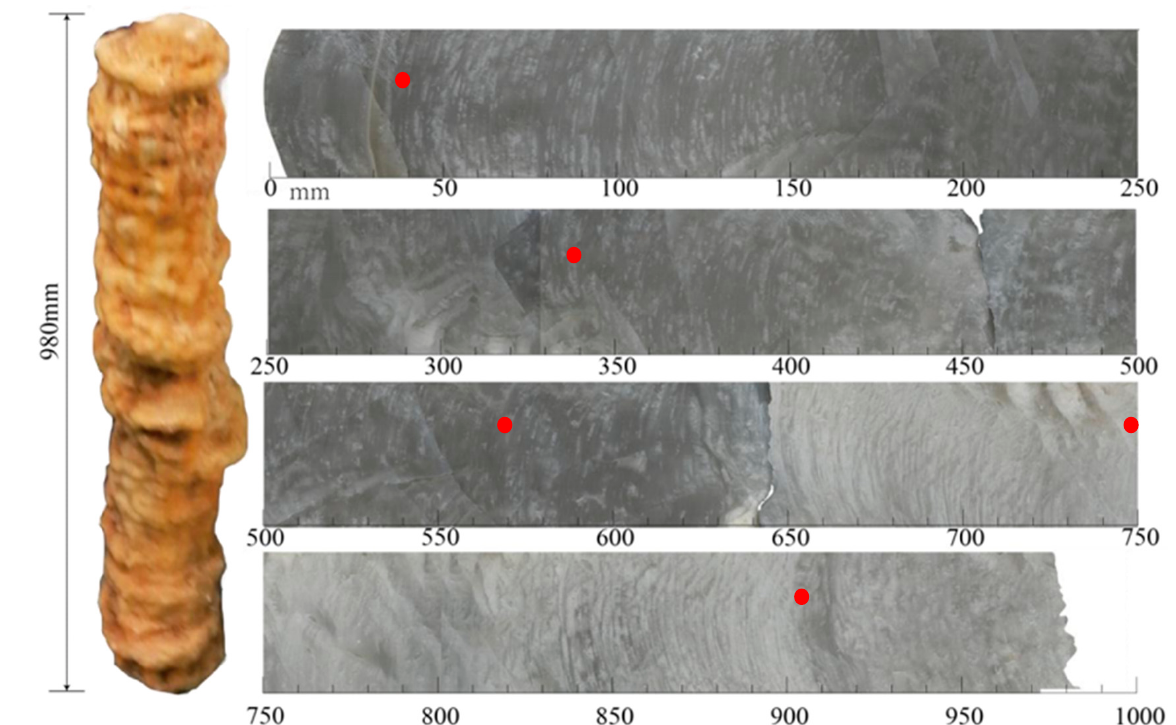
Figure 2. Photograph of stalagmite SYG1 from Shouyuangong Cave. The red dots indicate layers for 230 Th/U dating.